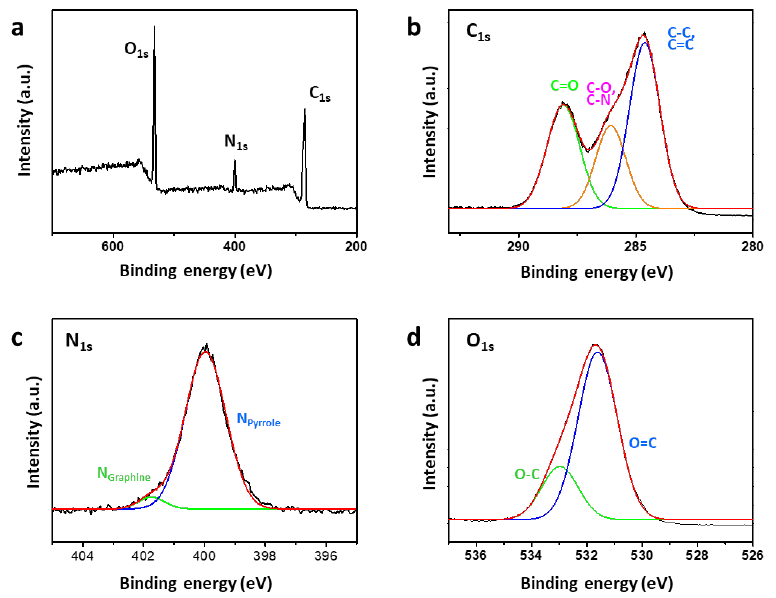
Figure 2. ( a ) X-ray photoelectron spectrometry survey scan profile and high-resolution ( b ) C 1s , ( c ) N 1s , and ( d ) O 1s spectra of Mn:N-CDs. ( c ) N 1s , and ( d ) O 1s spectra of